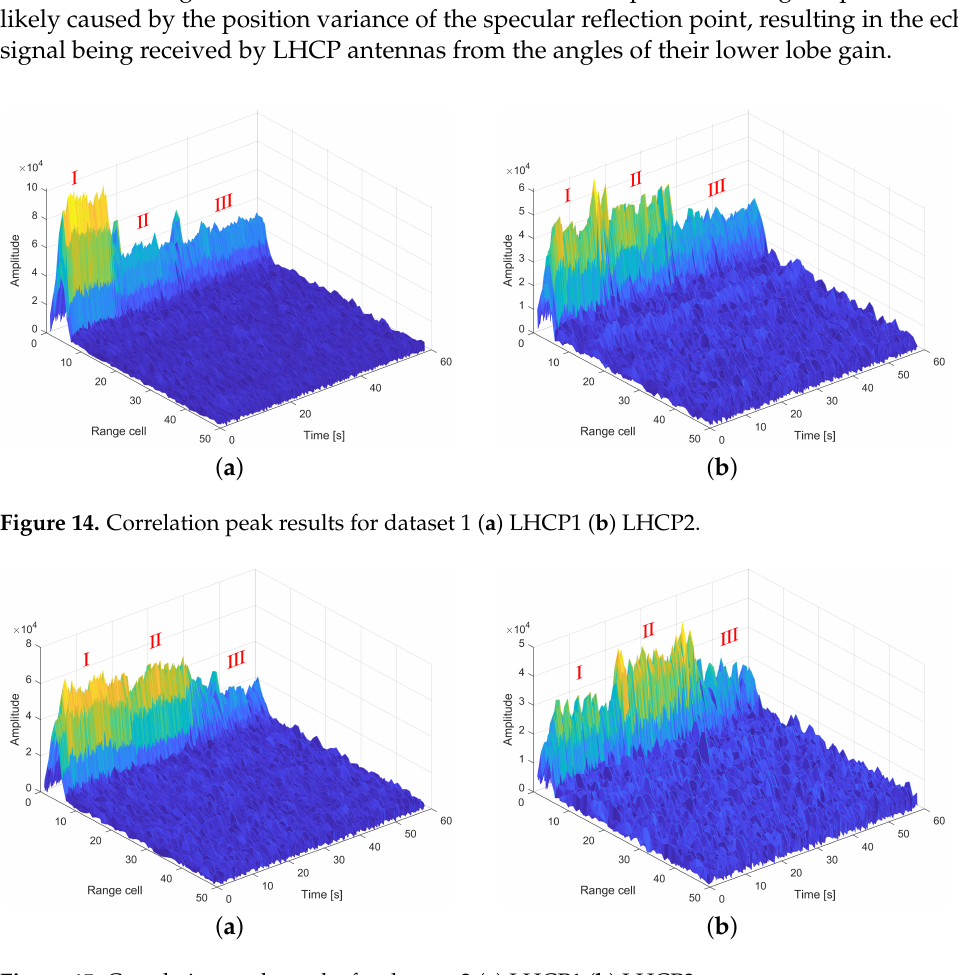
Figure 15. Correlation peak results for dataset 2 ( a ) LHCP1 ( b )